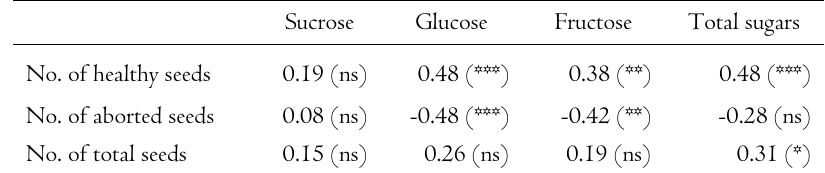
F IGURE 2. Growth of seedlings of Parkia biglobosa originating from 69 self-pollinated and 147 cross-pollinated seeds, showing the temporal development (days after sowing) of A) mean height, B) mean stem diameter, and C) mean number of pinnae. Error bars indicate ± 1 standard error of the mean. Only seedlings, which survived until harvest at 222 days after sowing are